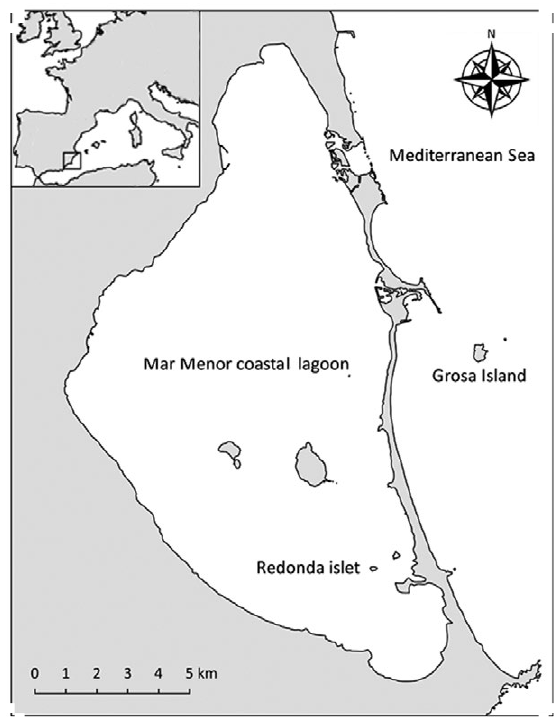
Fig. 1. – Location of the study area (western Mediterranean, region of Murcia, SE Spain: 37°46'00"N,